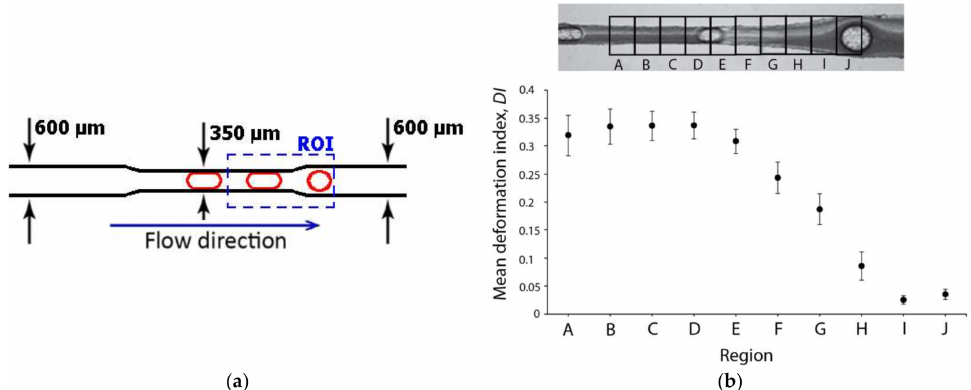
Figure 11. ( a ) Schematic representation of the microchannel contraction region and flow direction of a device to study gas embolisms [85]. The region of interest is indicated by a dotted rectangle; and ( b ) the mean deformation index of bubble flowing through the contraction